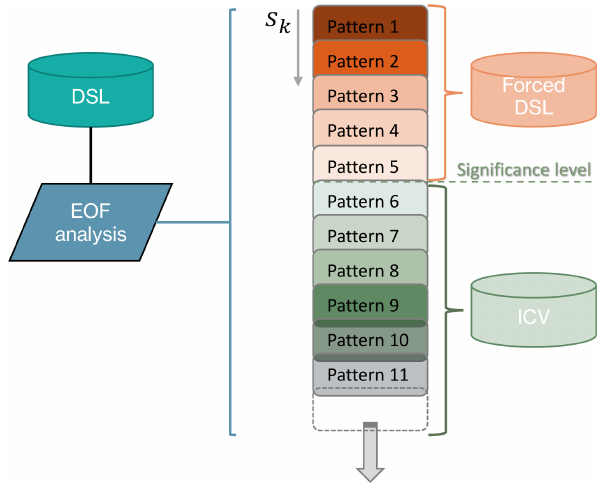
Figure 1. Main steps involved in isolating the forced response, in- cluding variability decomposition (EOF analysis), finding leading anomaly patterns, and combining leading patterns above a signifi- cant statistical